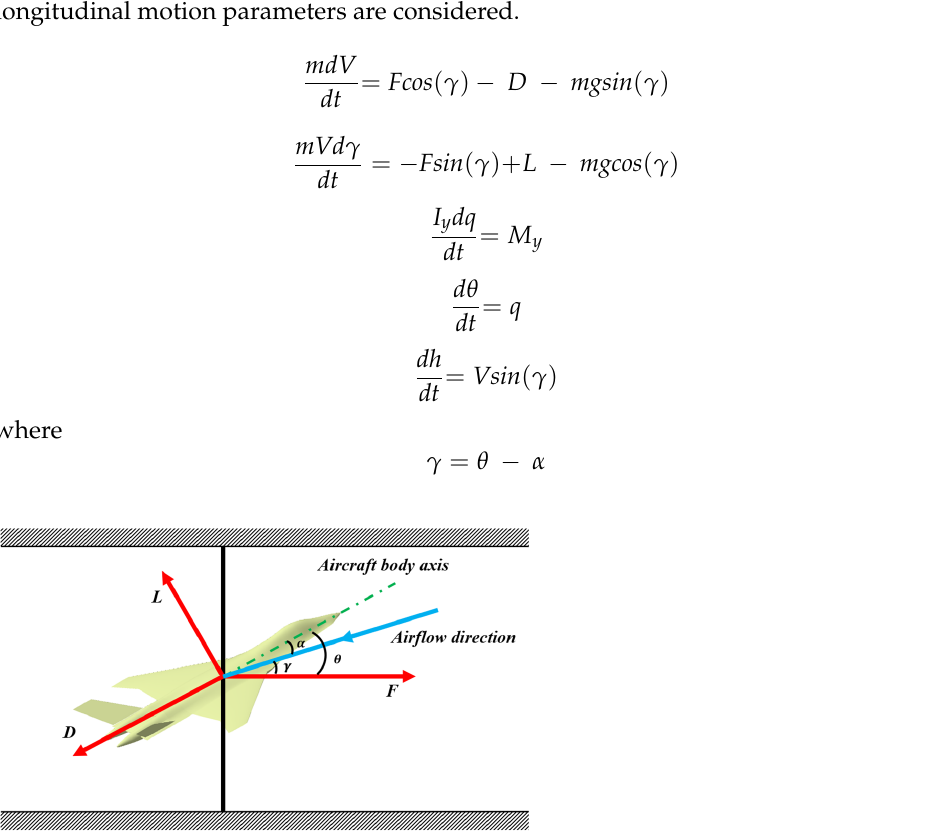
Figure 16. Force analysis of the aircraft installed in the present support system.